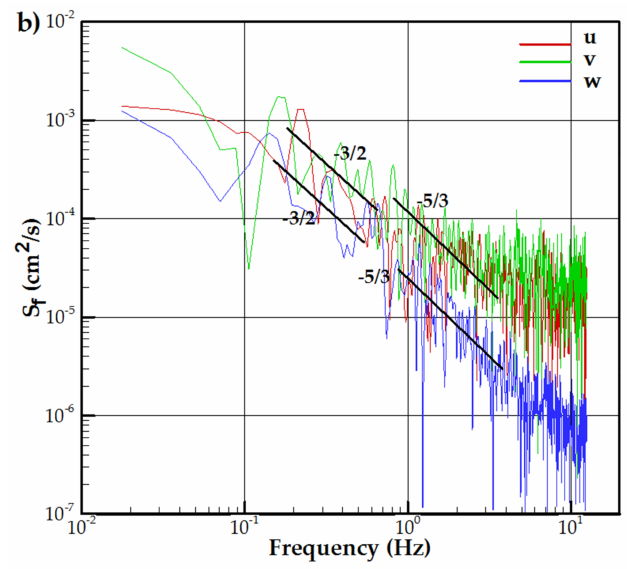
Figure 6. ( a ) Measured velocity signal at X13Y3Z2 for non-vegetated case; ( b ) Spectral distribution at X13Y3Z2 for h v 2 = 0.10